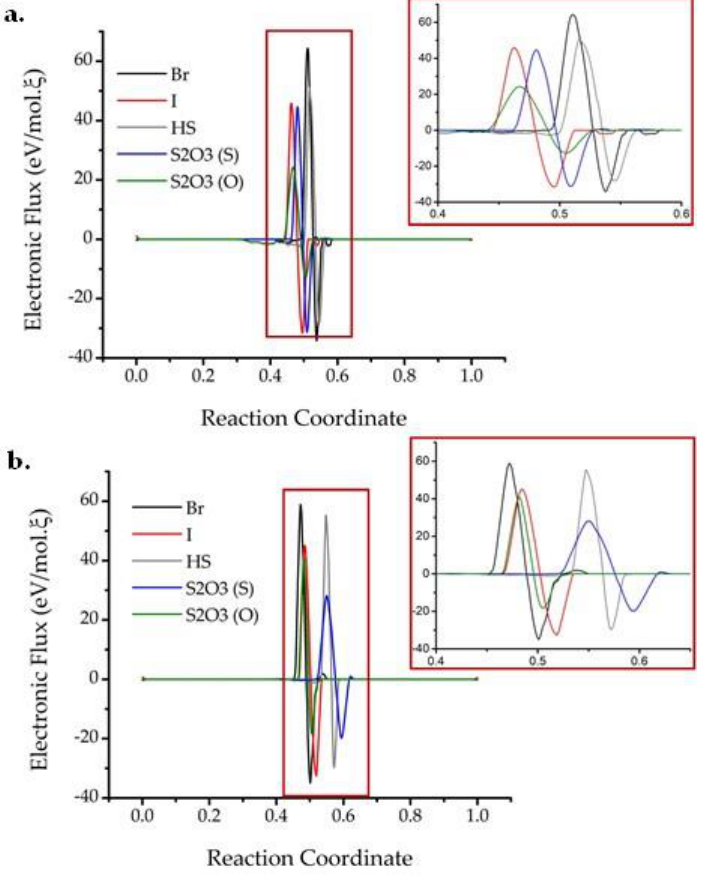
Figure 6. REF plots for the nucleophilic substitution of alachlor ( a ) and propachlor ( b ).